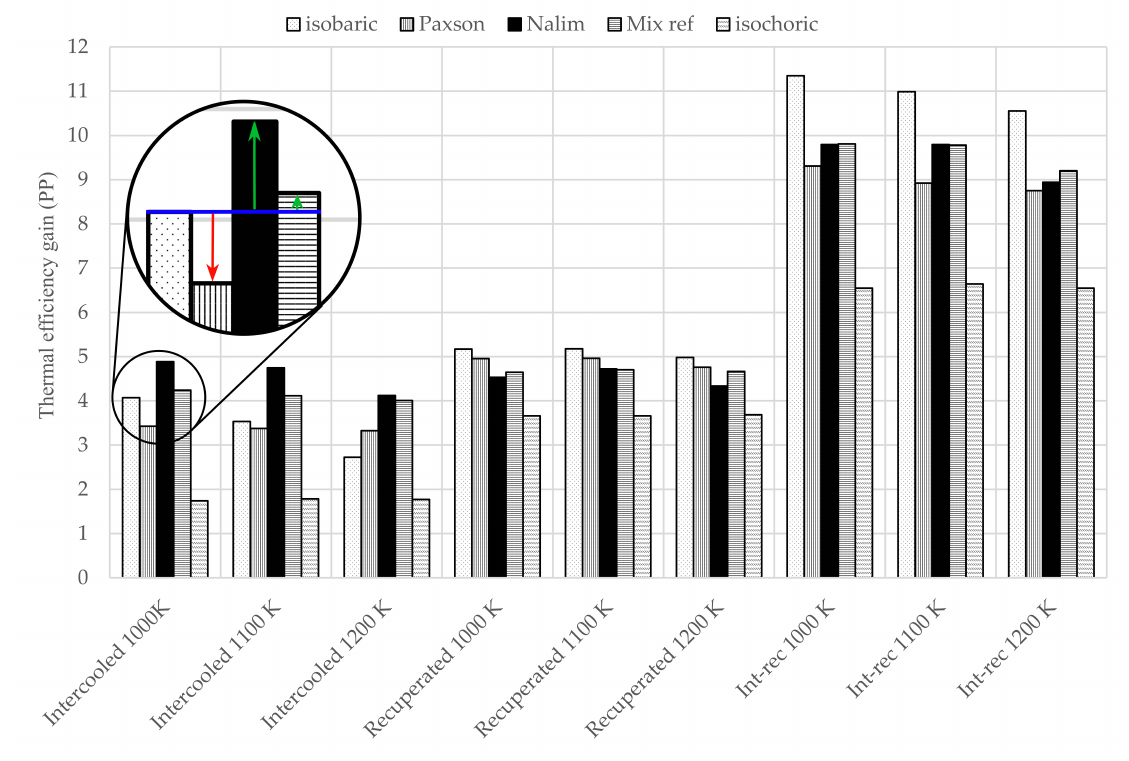
Figure 5. Thermal efficiency for various models and cycles at T mat of 1000K, 1100K, and 1200K. PP, percentage